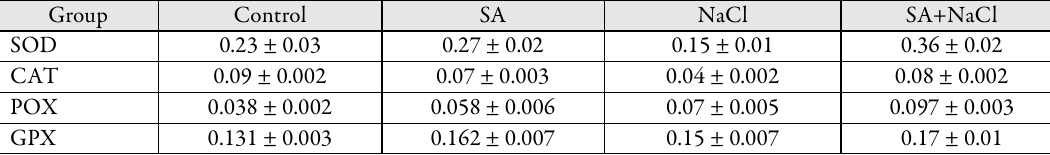
Table 1. Individual and combined effect of salinity and SA on antioxidant enzymes Group Control SA NaCl